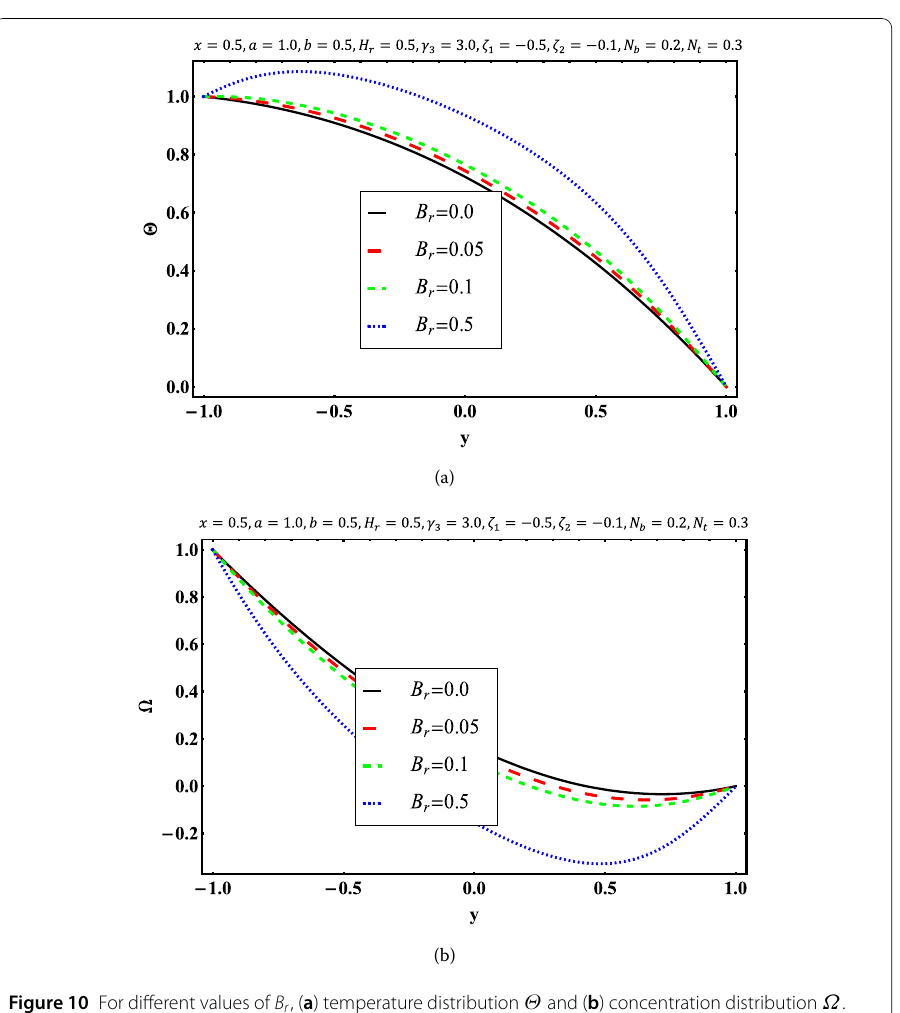
Figure 10 For different values of B r , ( a ) temperature distribution Θ and ( b ) concentration distribution Ω .